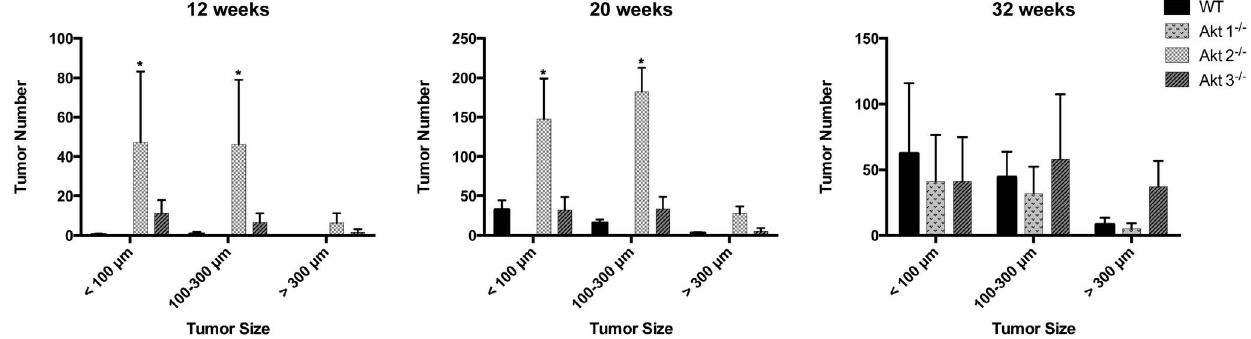
Figure 3. Ablation of Akt2 dramatically enhances the initiation of lung tumorigenesis in A JE JJenv infected mice. WT, Akt1 2 / 2 , Akt2 2 / 2 and Akt3 2 / 2 mice infected with A JE JJenv were euthanized at 12 (A), 20 (B) and 32 (C) weeks post infection and the number of lung tumors less than 100 m m, between 100 and 300 m m, and greater than 300 m m were quantified. Note that since all Akt2 2 / 2 mice died around the 20-week time point there is no data for Akt2 2 / 2 mice at the 32-week time point. Three lung lobes from three randomly selected mice per group were sectioned until the maximum surface area was exposed at which point all tumors within each lung lobe were counted. Bars on the graph labeled with an asterisk are statistically different (p , 0.05).